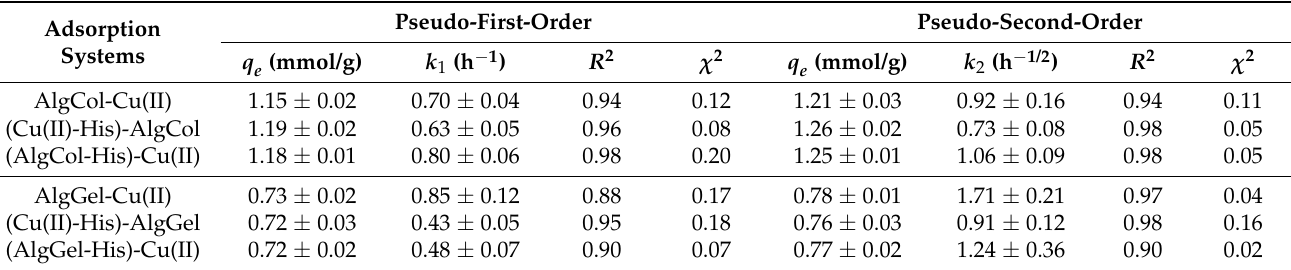
Table 2. Adsorption kinetic parameters for the pseudo-first-order and pseudo-second-order kinetic models. Parameters were retrieved by fitting the data for copper ion adsorption in AlgCol and AlgGel